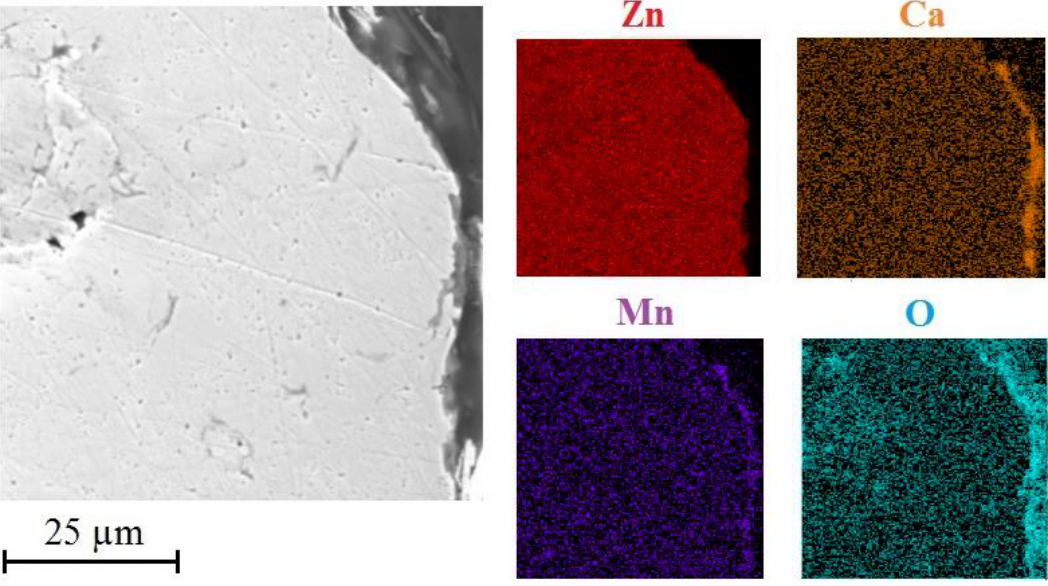
Figure 22. SEM—distribution of Zn/Ca/Mn/O on cross section in precipitate of corrosion products (exposure in simulated concrete pore solution with KMnO 4 (Mn (2) )).